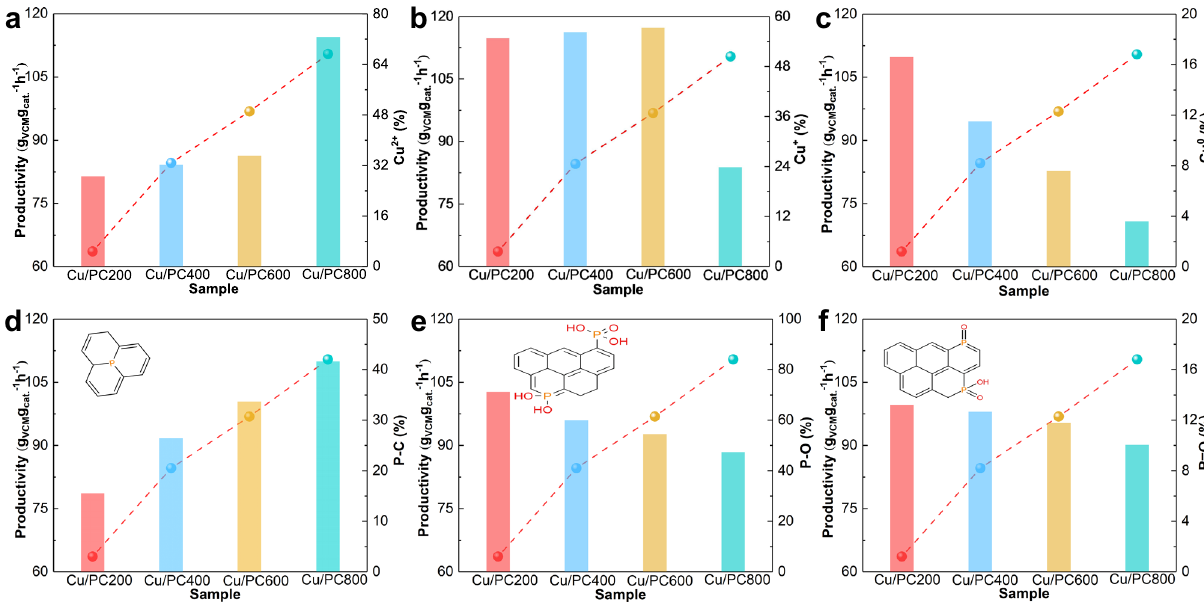
Fig. 4 Correlation diagram of productivity and various species content. Correlation diagram of a – c copper species content, d – f phosphorus species content and